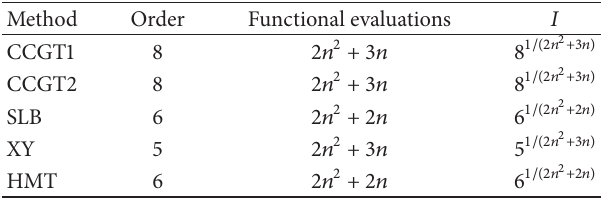
Table 1: Efficiency index for different